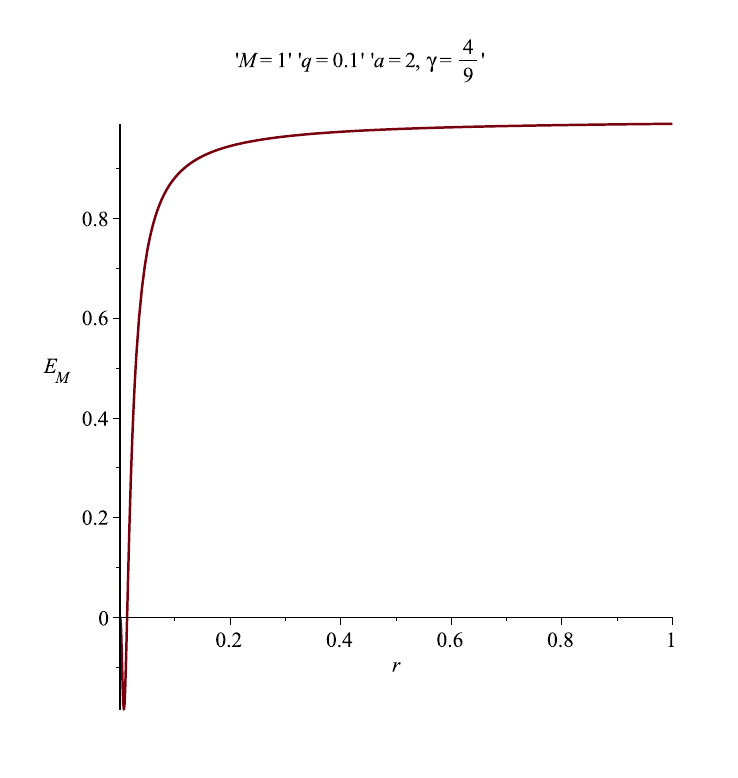
Figure 7. Møller energy versus the radial distance r